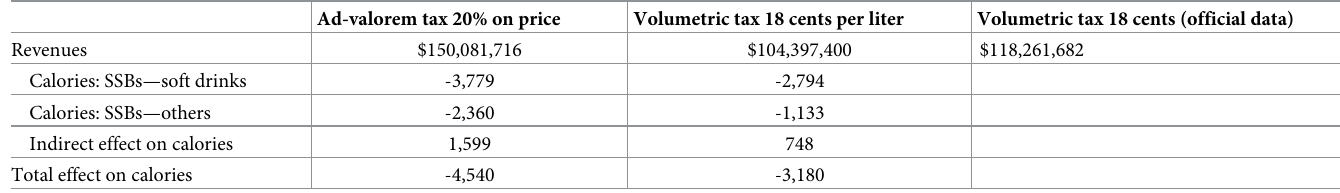
Table 5. Policy impact simulation: Revenues and caloric change, whole